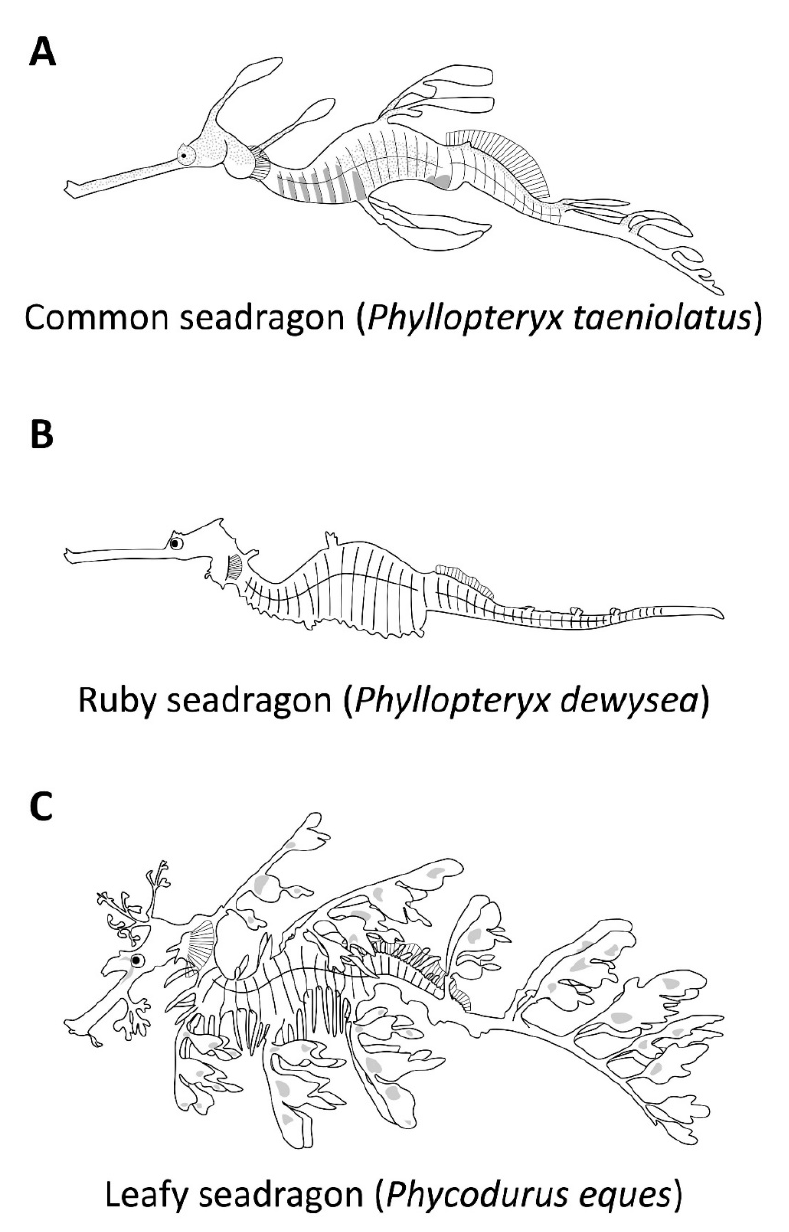
Figure 1. Illustrating the three extant seadragon species (( A ): common seadragon; ( B ): ruby seadragon; ( C ): leafy seadragon), all endemic to Southern Australia (drawings by Elaine Chu).